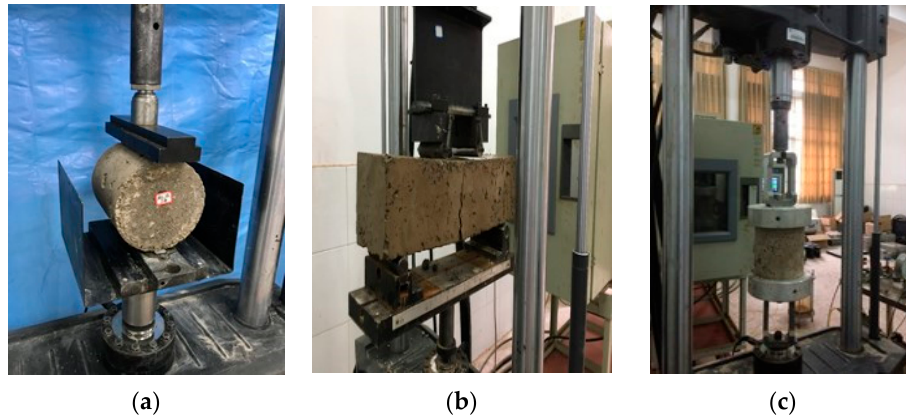
Figure 5. Images of strength and fatigue test procedures: ( a ) indirect tensile specimen, ( b ) flexural tensile specimen, and ( c ). unconfined compressive specimen